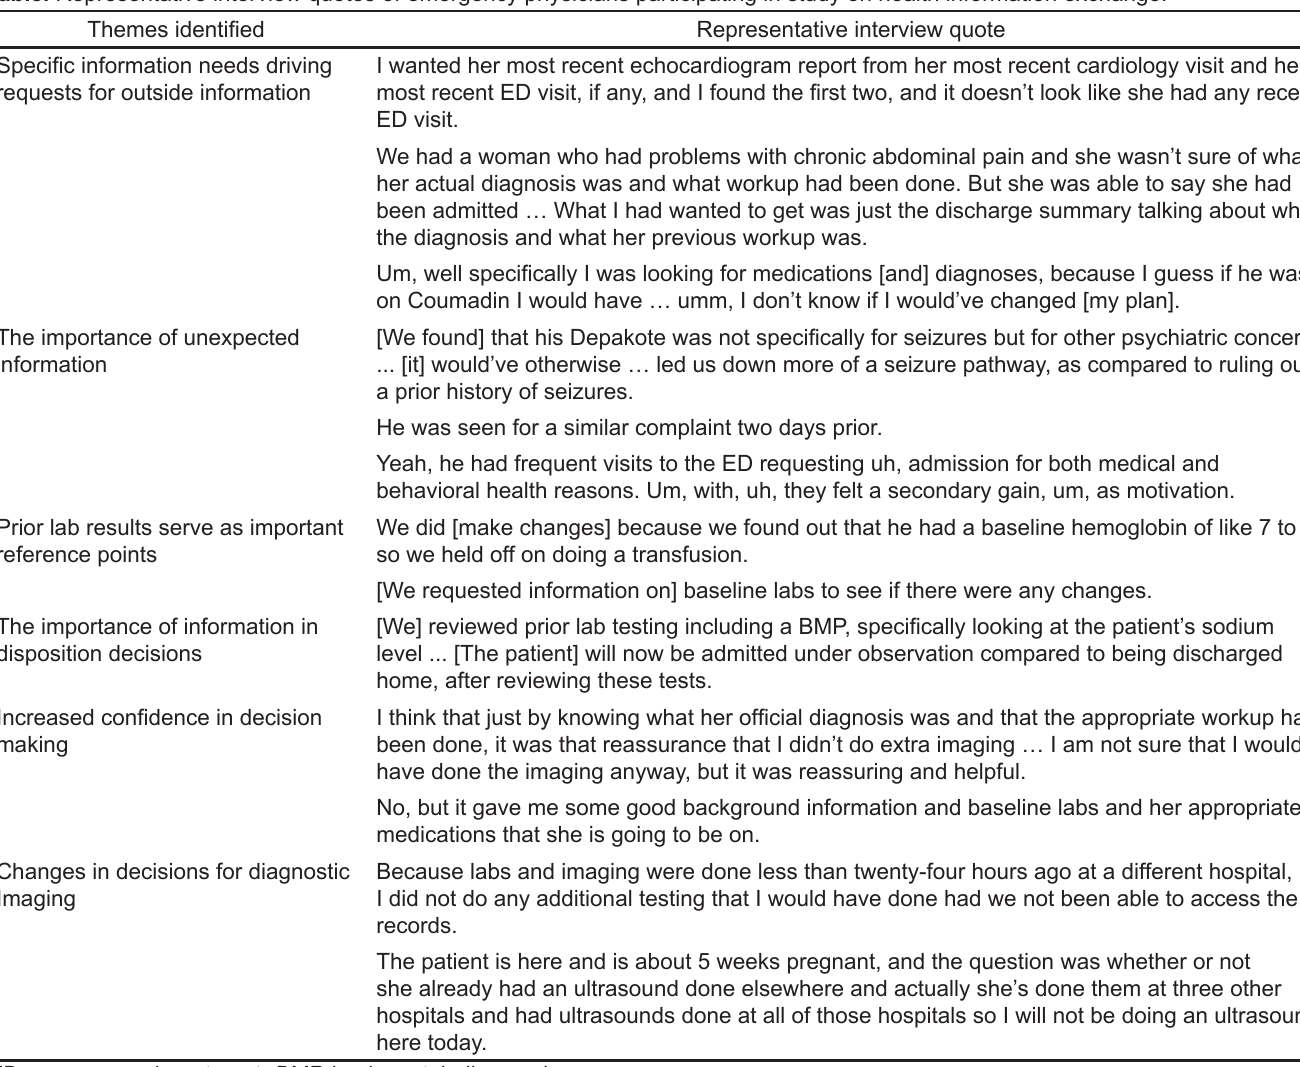
Table. Representative interview quotes of emergency physicians participating in study on health information